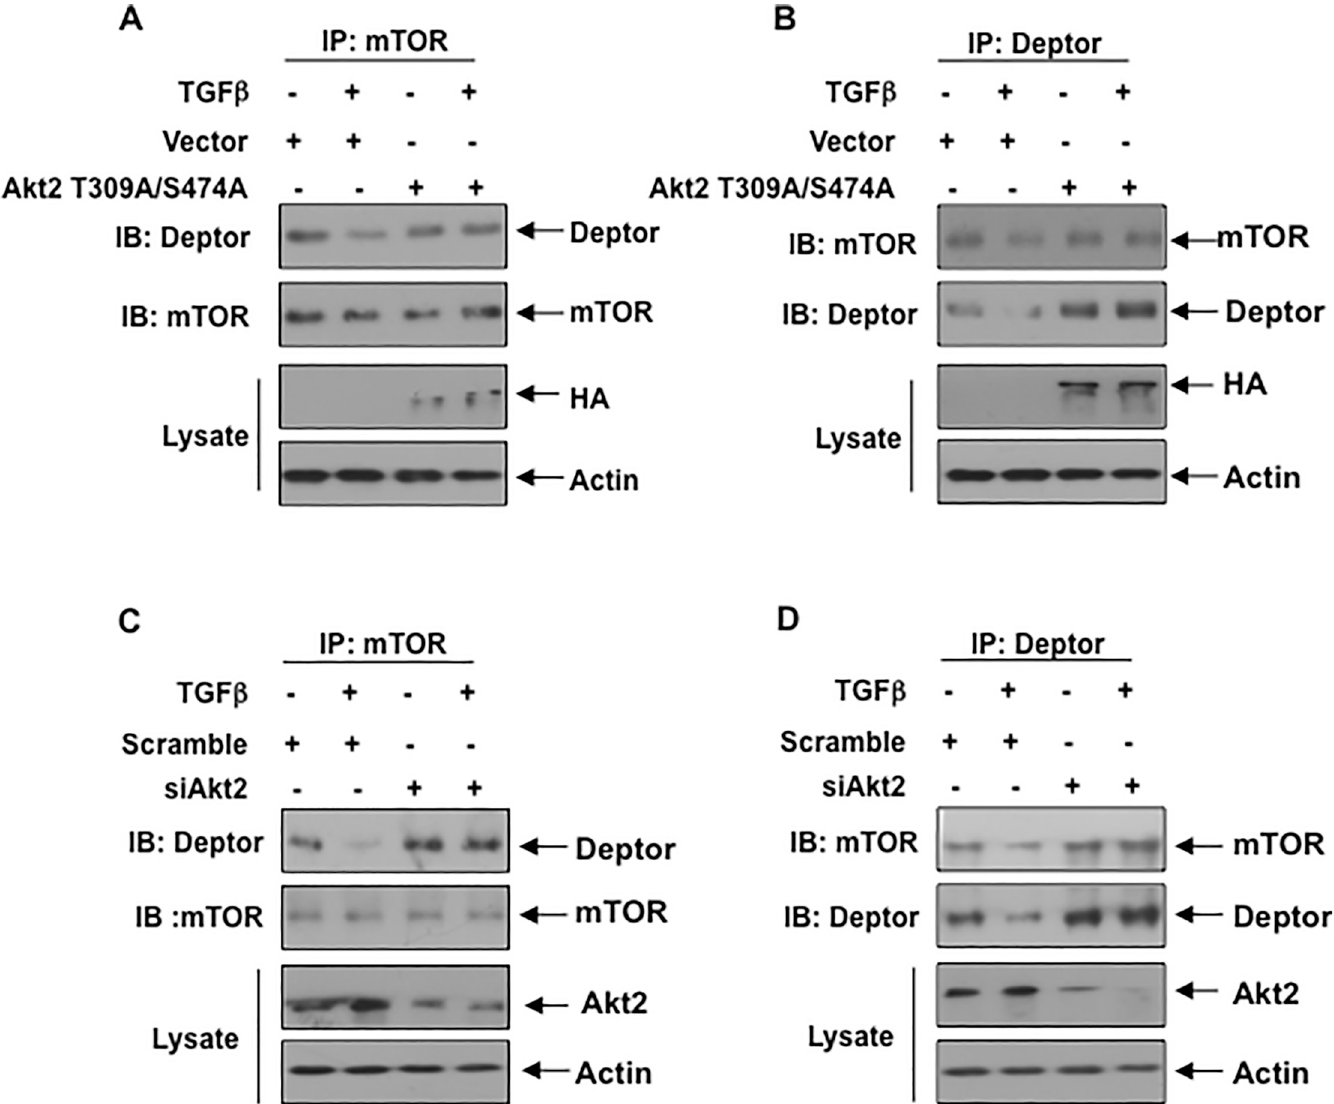
Fig 8. Phospho-deficient mutant of Akt2 and siRNA against Akt2 prevent dissociation of deptor from mTOR by TGF β (A and B) Podocytes were transfected with Akt2 T309A/S474A mutant plasmid. The transfected cells were starved and incubated with TGF β The cell lysates were immunoprecipitated with mTOR (panel A) and deptor (panel B). The immunoprecipitates were immunoblotted with deptor and mTOR antibodies as indicated. Also, the total cell lysates were immunoblotted with HA and actin antibodies (bottom two panels). (C and D) The cells were transfected with scramble RNA or siRNA against Akt2. The transfected cells were immunoprecipitated with mTOR (panel C) and deptor (panel D). The immunoprecipitates were immunoblotted with deptor and mTOR antibodies as indicated. Also, the total cell lysates were immunoblotted with Akt2 and actin antibodies (bottom two panels). Representative of 3 independent experiments is shown. The quantification is shown in the S11